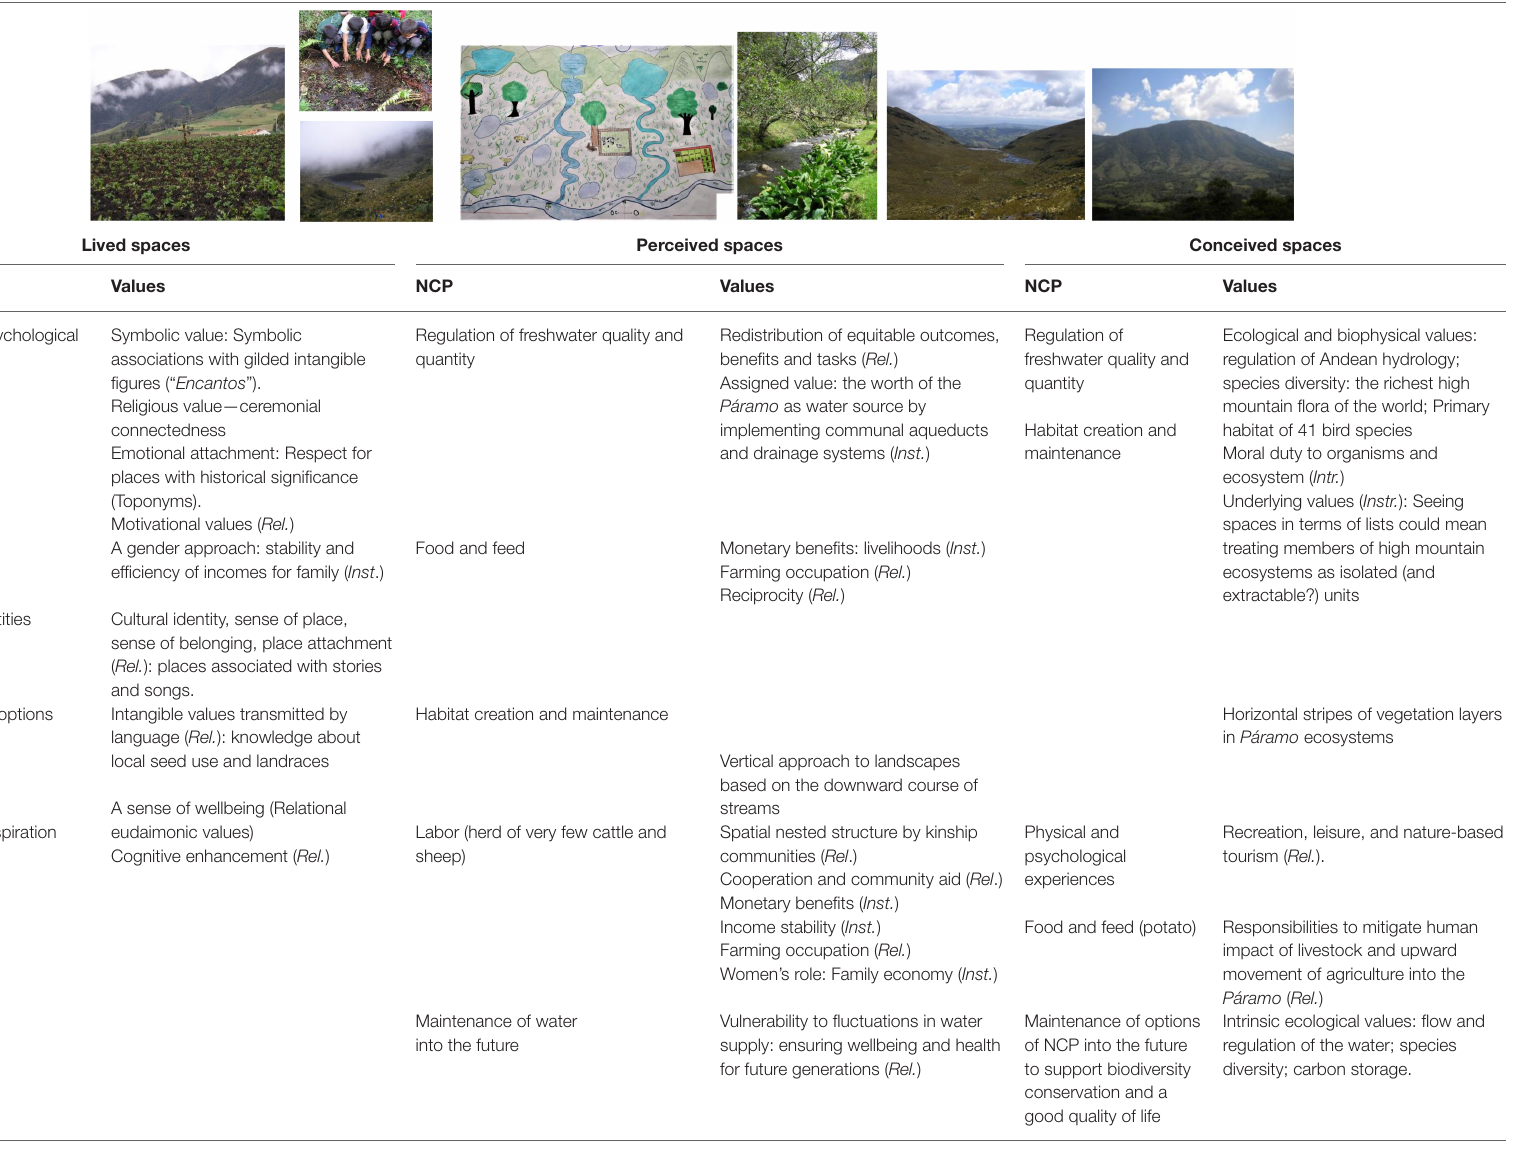
TABLE 2 | Potato farming ( Solanum tuberosum ,